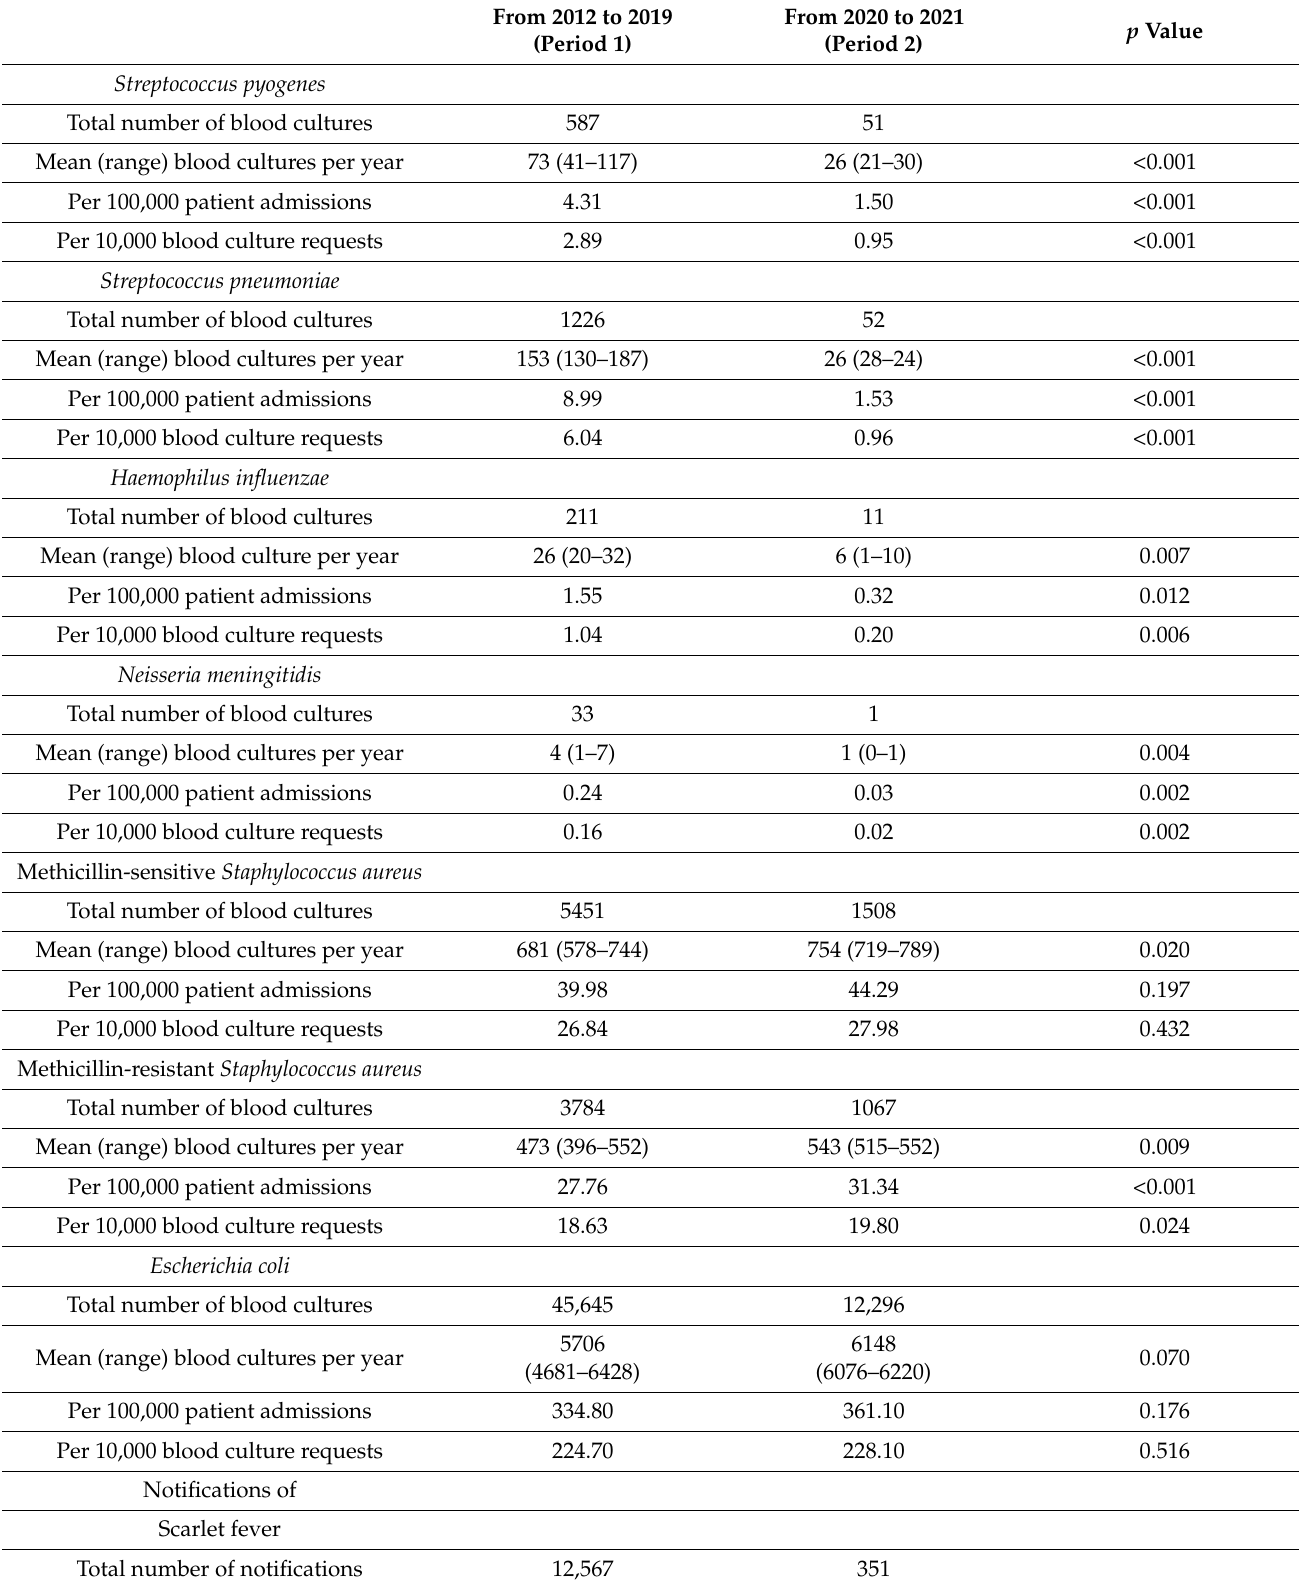
Table 1. Community-onset bacteremia of selected pathogens and notifications of scarlet fever, tuber- culosis, and chickenpox before and during the COVID-19 pandemic in Hong Kong a